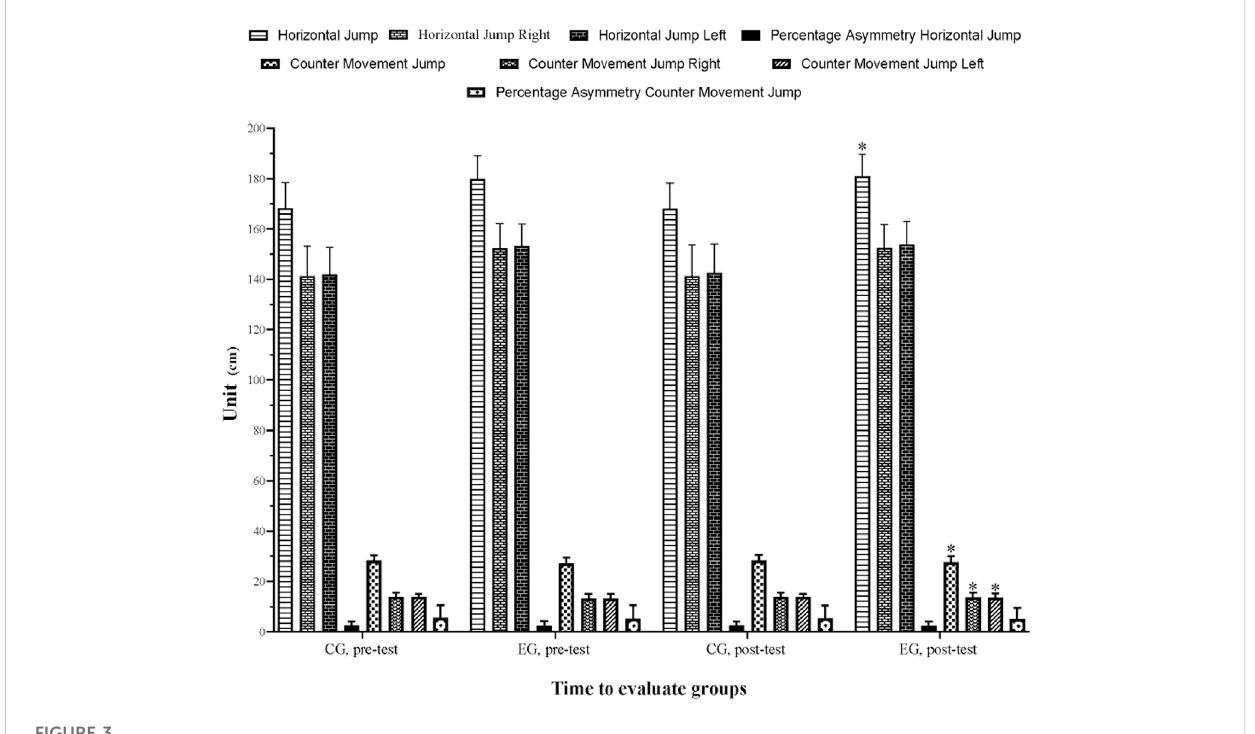
FIGURE 3 Variation in jump variables for control and experimental